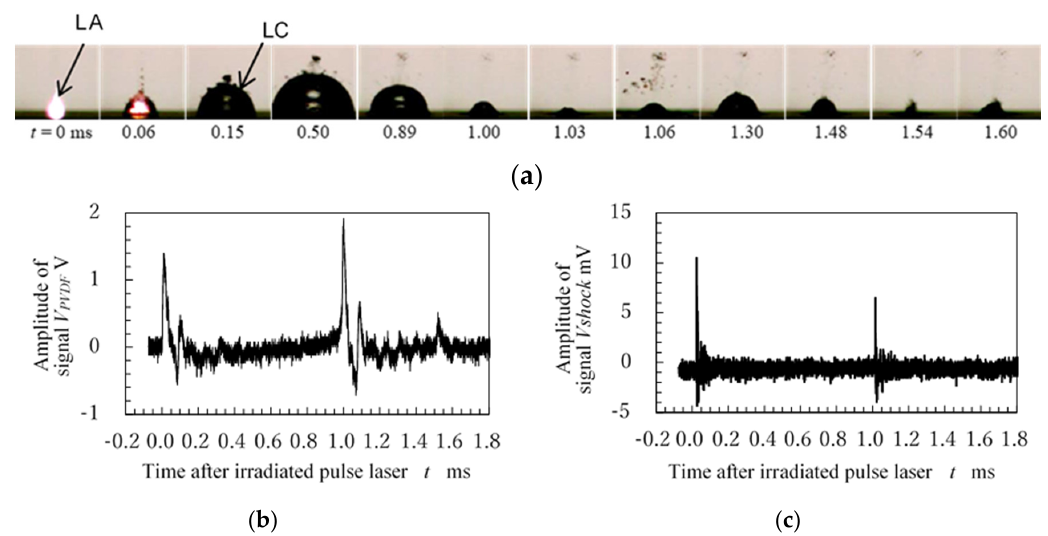
Figure 11. Laser ablation (LA) and laser cavitation (LC) produced by a pulse laser. ( a ) Aspect of laser ablation (LA) and laser cavitation (LC); ( b ) Signal from polyvinylidene fluoride (PVDF) sensor; ( c ) Signal from submerged shockwave sensor.